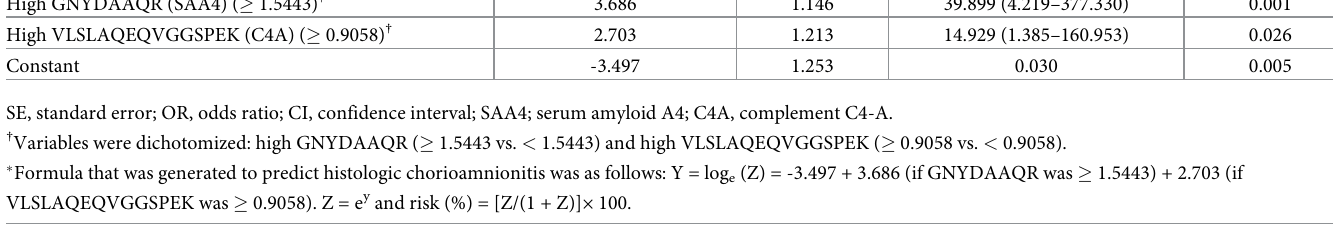
Table 4. Regression coefficients, odds ratios, and 95% confidence intervals of the best protein panel � for predicting histologic chorioamnionitis.